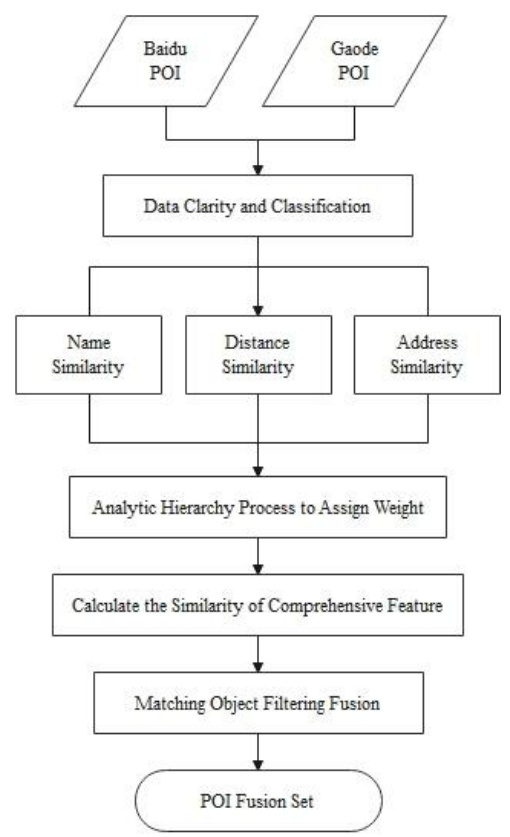
Figure 1 . POI matching and fusion technology